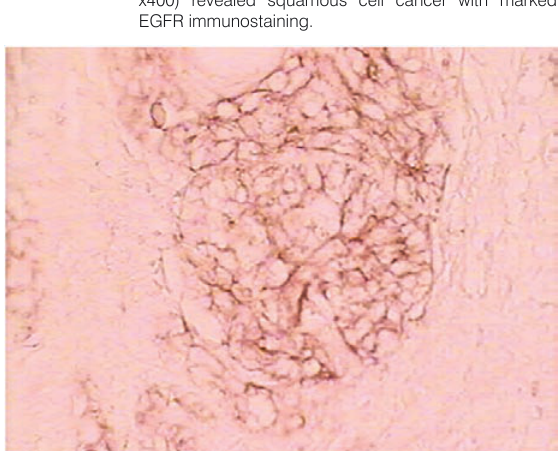
Figure 1. A preoperative CT of the liver – a large low-enhancing lesion in the right lobe is demonstrated.